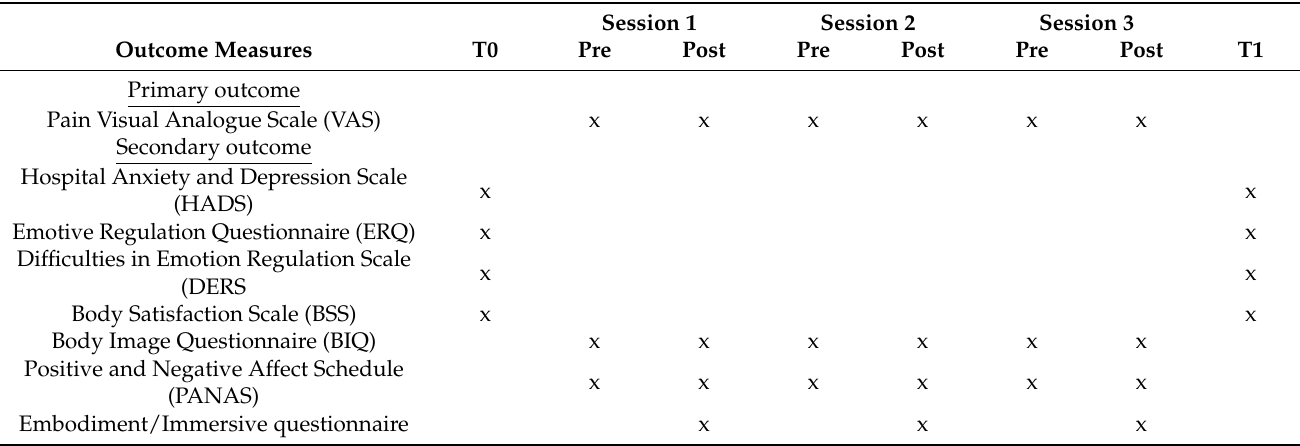
Table 1. Materials for participant evaluation as a function of the testing